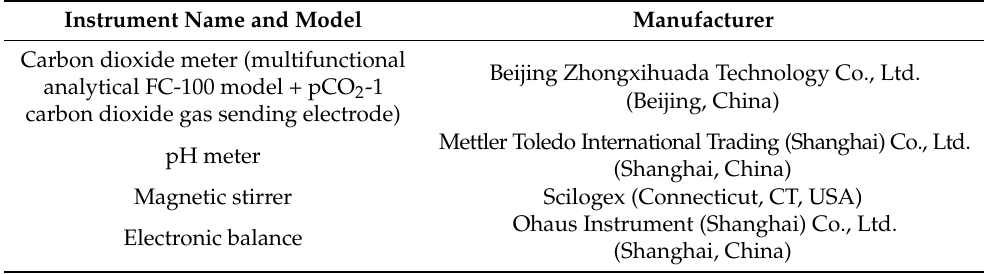
Table 2. Major instruments and devices.